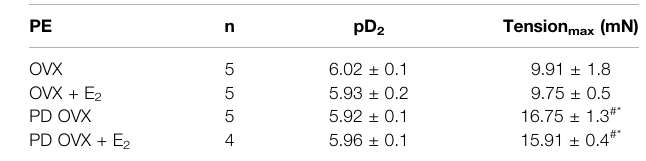
TABLE 4 | Sensitivity (pD 2 : logEC 50 ), and Tension max to phenylephrine (PE) in rat mesenteric arterial rings from ovariectomized (OVX) and E 2 replaced (OVX + E 2 ) control and prediabetic (PD)